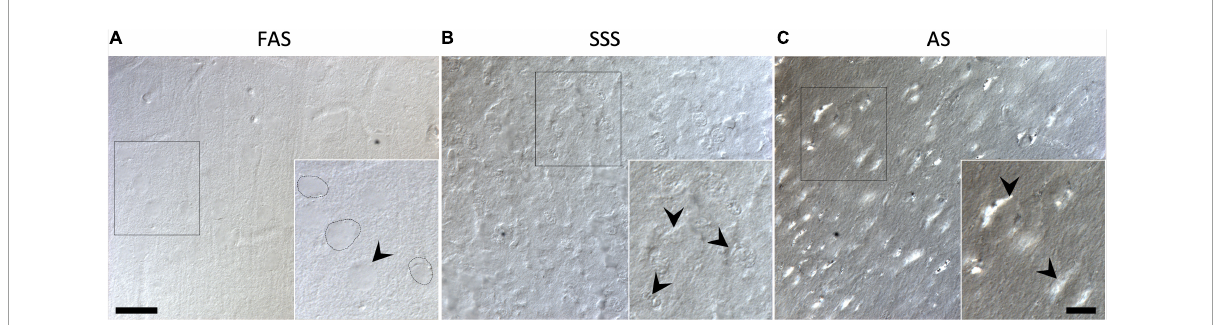
FIGURE8 Tissue integrity of the immunofluorescence processed slices. Photomicrographs (60X) of DIC illuminated tissue slices of the immunofluorescence negative control slices showing the texture of the brain tissue when fixed with (A) FAS, (B) SSS, and (C) AS. Insert in A shows regular cell contours and smooth neuropil. Black arrowheads in insert (B) show shrunken and shriveled cells, while showing a broken neuropil in insert (C) . Left scale bar = 25 µ m [valid for (A–C) ]. Right scale bar = 10 µ m (valid for all three